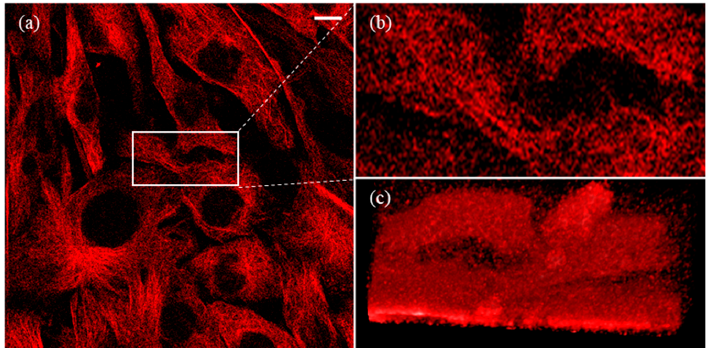
Figure 1. Original confocal image of 3T3 cell microtubule. ( a ) Image has 512 × 512 pixels, with a dot pitch of 250 nm. ( b ) The zoomed-in image of the white box. ( c ) The three-dimensional (3D) reconstruction of ( b ). The white scale bar represents 10 µm (for further details on the 3D structure of Figure 1 ( c ), see Supplementary Video S1).